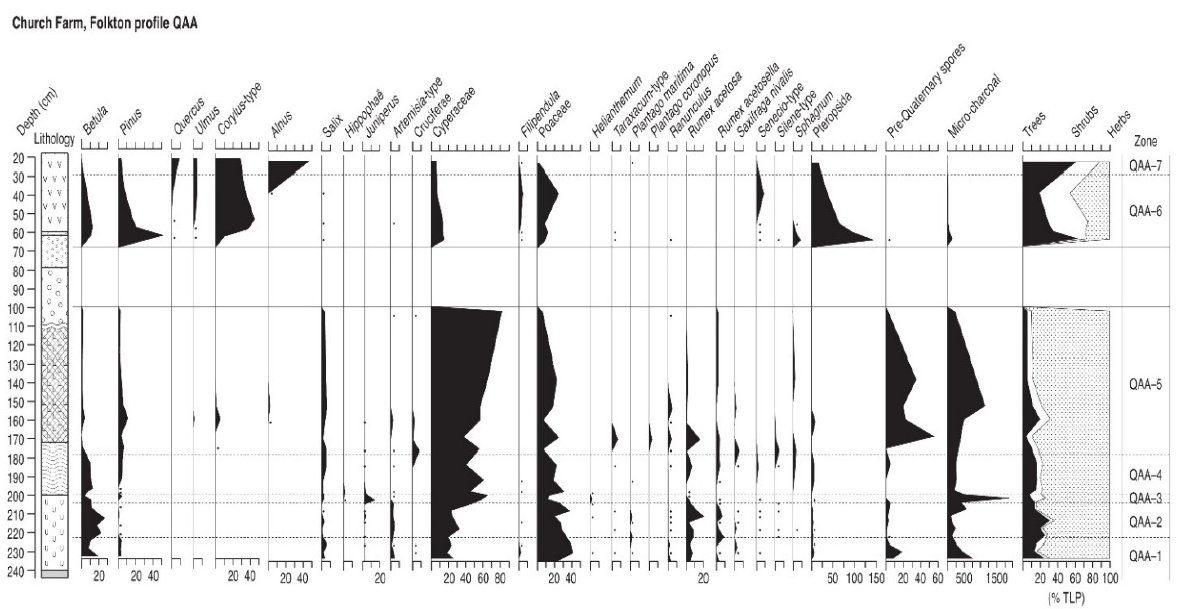
Figure 10. Percentage pollen diagram from Church Farm Folkton profile QAA. (Analysis GEC).